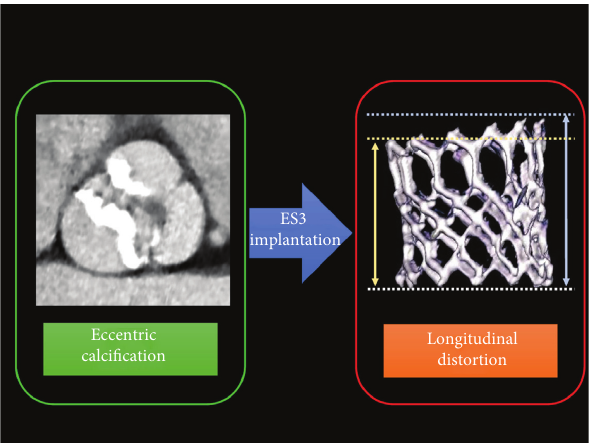
Figure 5: Eccentricity of aortic valvular calcification and trans- catheter heart valve distortion. Eccentricity of aortic valvular calcification was associated with longitudinal distortion of Edwards SAPIEN3 (ES3, Edwards Lifesciences, Irvine,